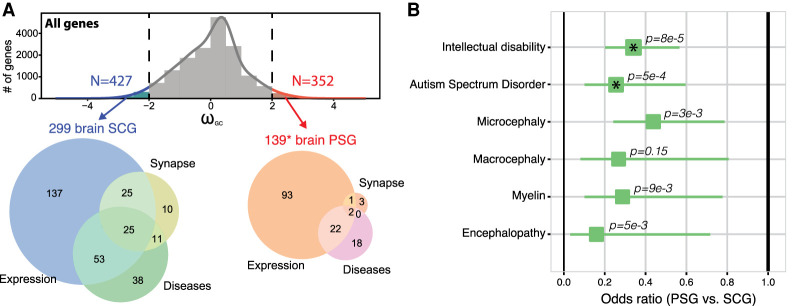
Brain protein-coding genes and human diseases. (A) Distribution of ωGC12 and Venn diagrams describing SCGs and PSGs situated at the extremes of the ωGC12 distribution (>2SD) specifically expressed in the brain (genes with specificity Z-score > 2 in any brain-related tissues of Figs. 1D and 2A), related to the synapse or brain diseases (Supplemental Table S4). (*) Addition of four genes (FARSB, KRT14, NPHS1, RSPH1) containing Homo sapiens–specific mutations predicted as deleterious (CADD>15). (B) Odds ratios for protein-coding gene sets related to brain diseases (Fisher's exact test; asterisks indicate P-values significant after Bonferroni correction; horizontal lines indicate 95% confidence intervals).